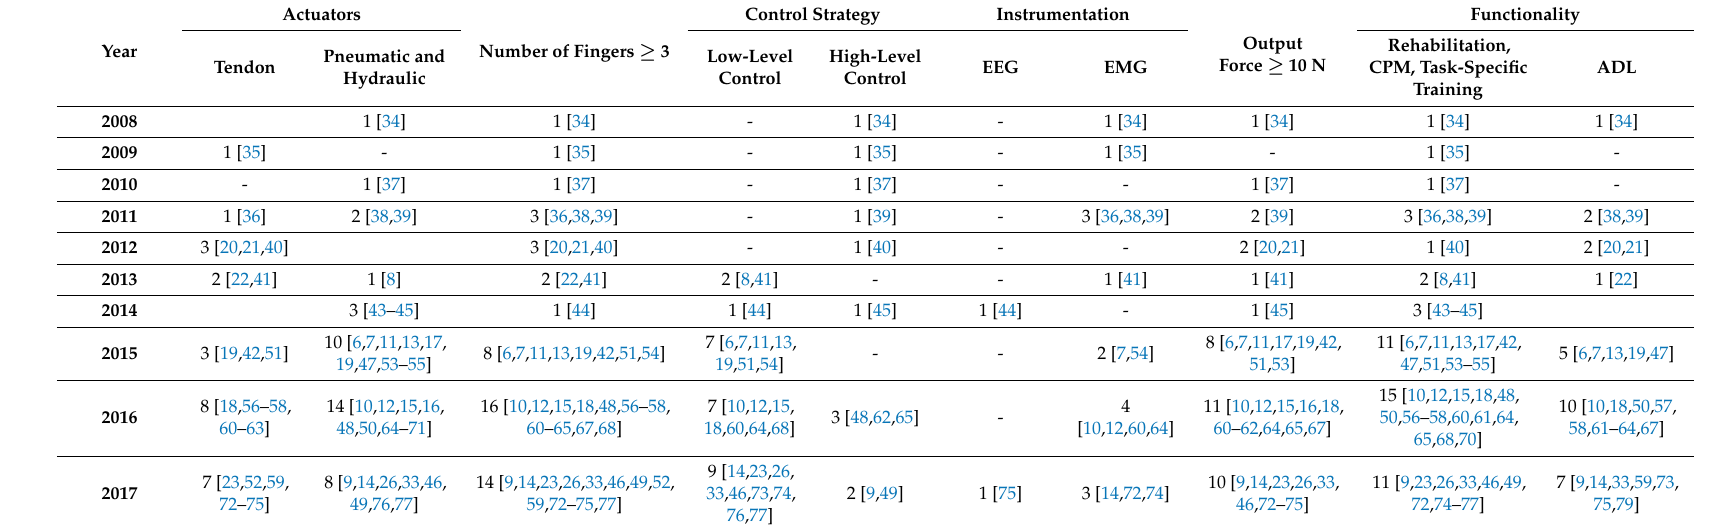
Table 2. Number of articles on soft robotic hand exoskeletons since